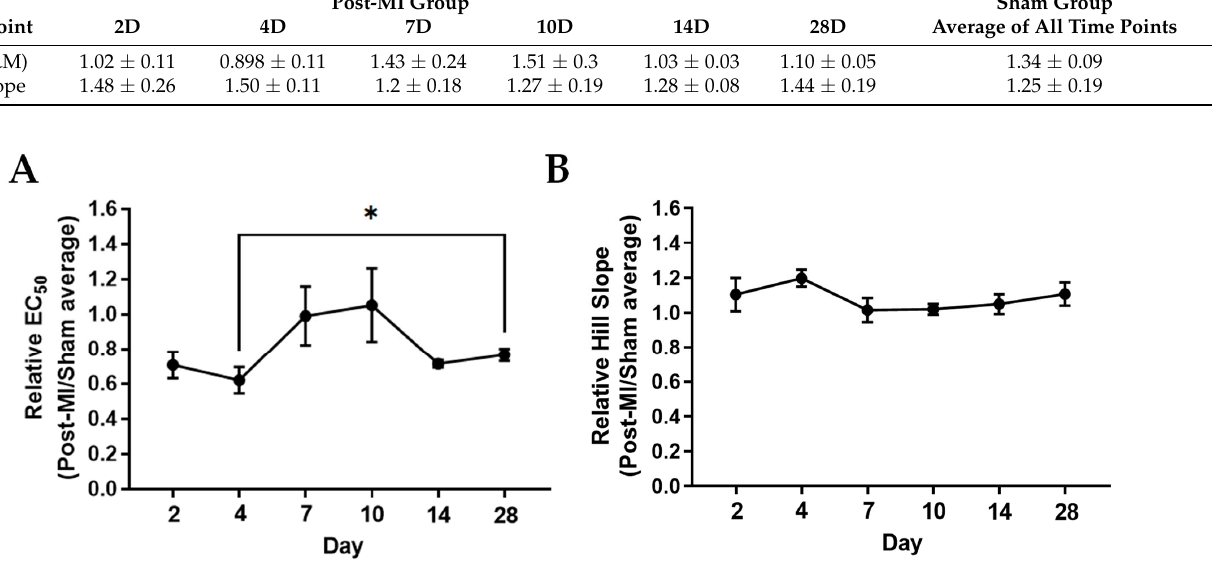
Figure 3. Ca 2+ sensitivity and cooperativity changes during MI progression. ( A ) Relative EC 50 and ( B ) relative Hill slopes (post-MI/sham average) plotted by mouse. Each data point is the average of at least three muscle preparations from the cardiac papillary of one mouse. Note: n = 3–5, where ‘ n ’ refers to the number of mice used. One-tailed unpaired t-test was performed between timepoints. Note: * p < 0.05 Kruskal–Wallis test was used on EC 50 of samples and ordinary one-way ANOVA was used on Hill slope of samples. There were no significant differences among the samples of the respective